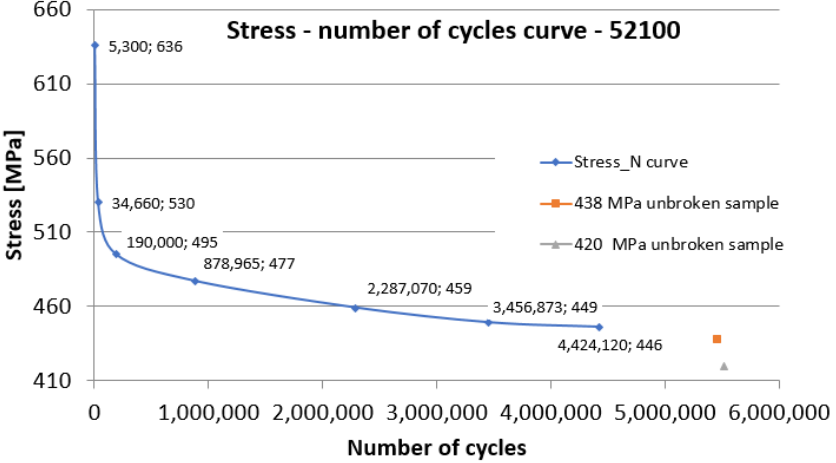
Figure 14. W ӧ hler curve for fatigue test of the 52100-steel coated with WIP-C1 powder. Figure 14. Wöhler curve for fatigue test of the 52100-steel coated with WIP-C1